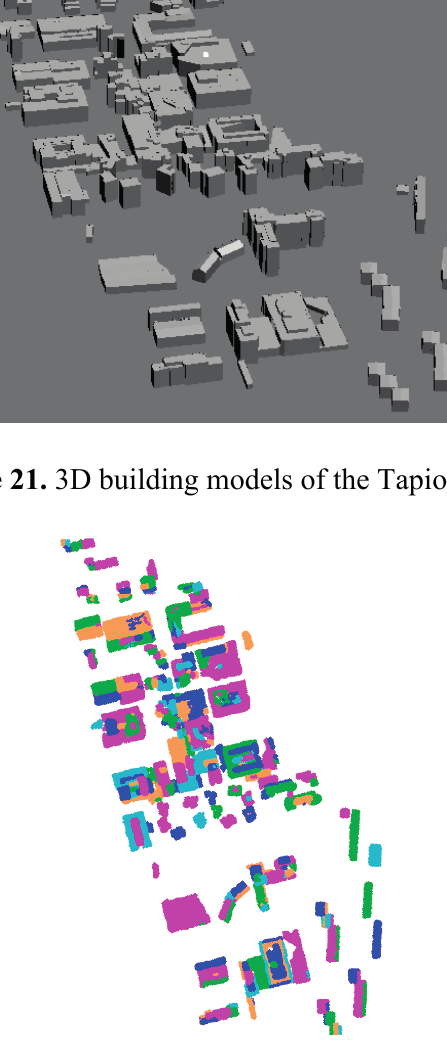
Figure 22. Extracted building roof patches. The different colors represent different